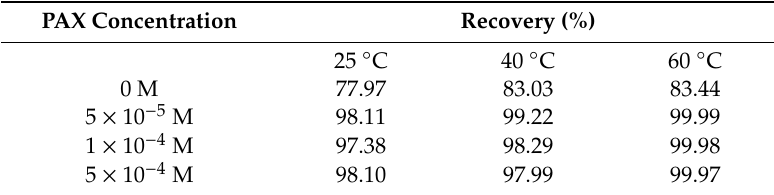
Table 1. Hallimond tube flotation recovery of chalcopyrite.